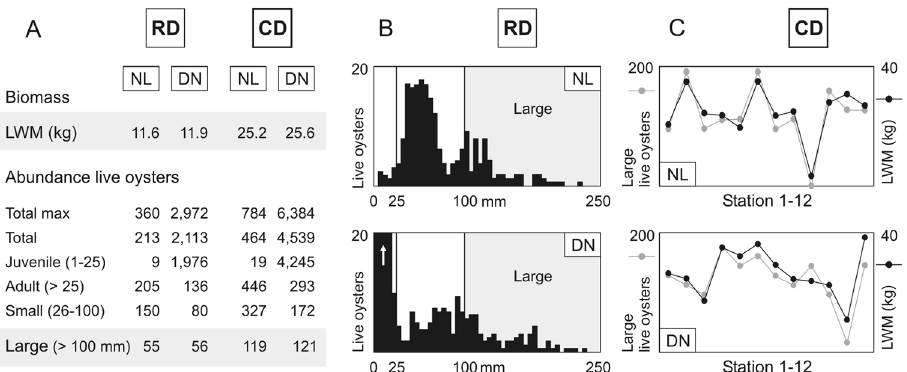
Figure 9. Density of live oysters at site NL on 01-04-2008 and site DN on 29-03-2011. A Density at- tributes LWM (kg) and abundance per areal reference RD and CD. B Length frequency distribution of live oyster RD. C Density attributes LWM (kg) and large live oyster CD at the 12 monitoring stations. Density metrics and density attributes according to Figure